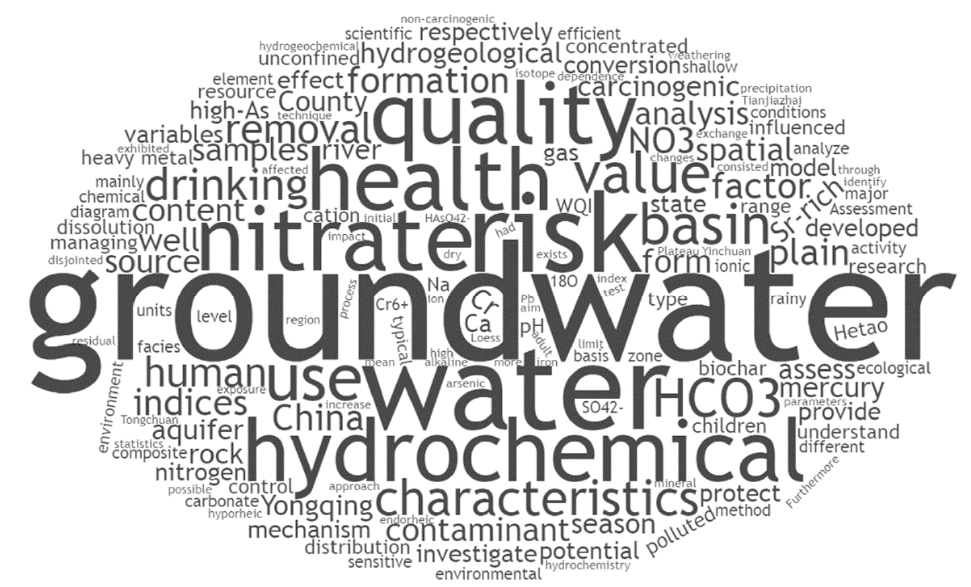
Figure 1. Word cloud generated with titles and abstracts of the Special Issue papers.